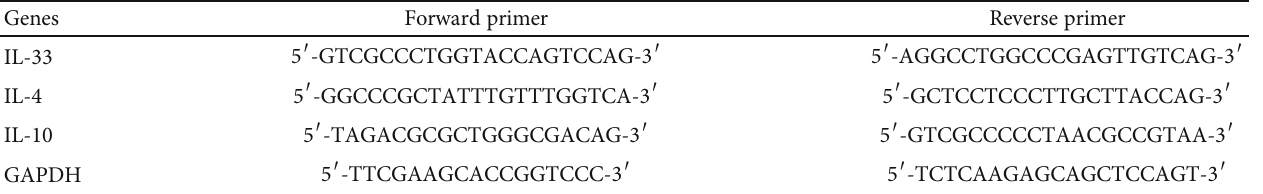
Table 1: Sequences of primers for